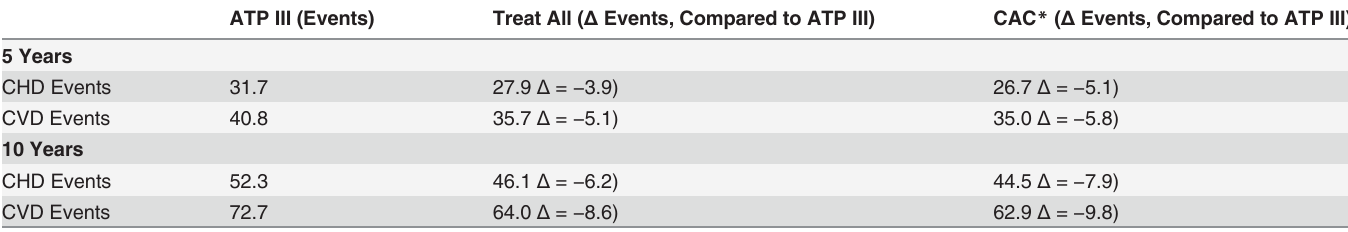
Table 3. Averted CHD and CVD Events Per 1,000 Persons, Base-Case MESA Event